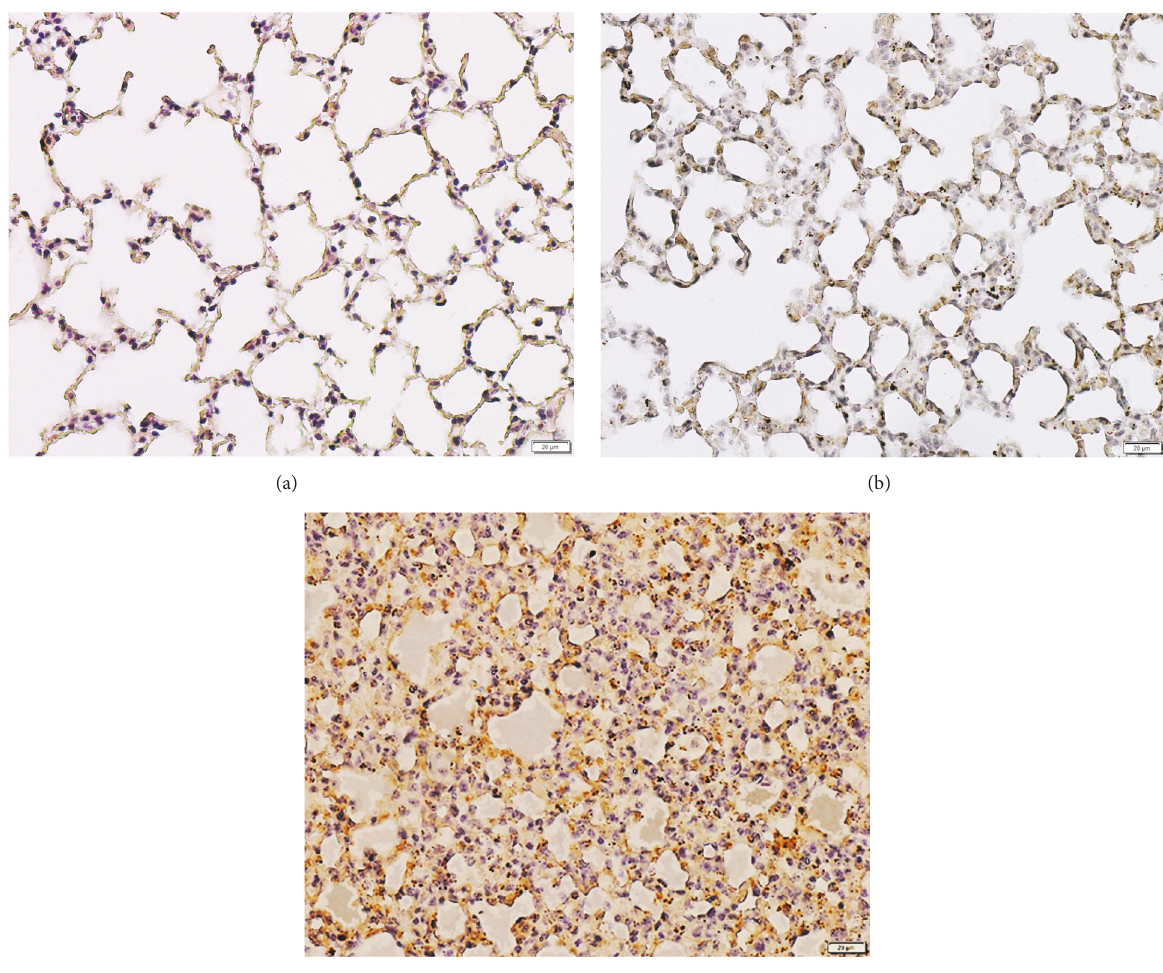
Figure 1: Representative photomicrographs of SP-D expression in the lung tissues. (a) Lung tissue of the mice in the control group, (b) lung tissue of the malaria-infected mice in the non-ALI/ARDS group, and (c) lung tissue of the malaria-infected mice with ALI/ARDS. All the images are magnified 400 × . Scale bar = 20 𝜇 m. Notice alveolar type I cells are thin and flat whereas alveolar type II cells are cuboidal. Alveolar macrophages are pleomorphic in shape, adhered to the internal surface of alveolar septum.